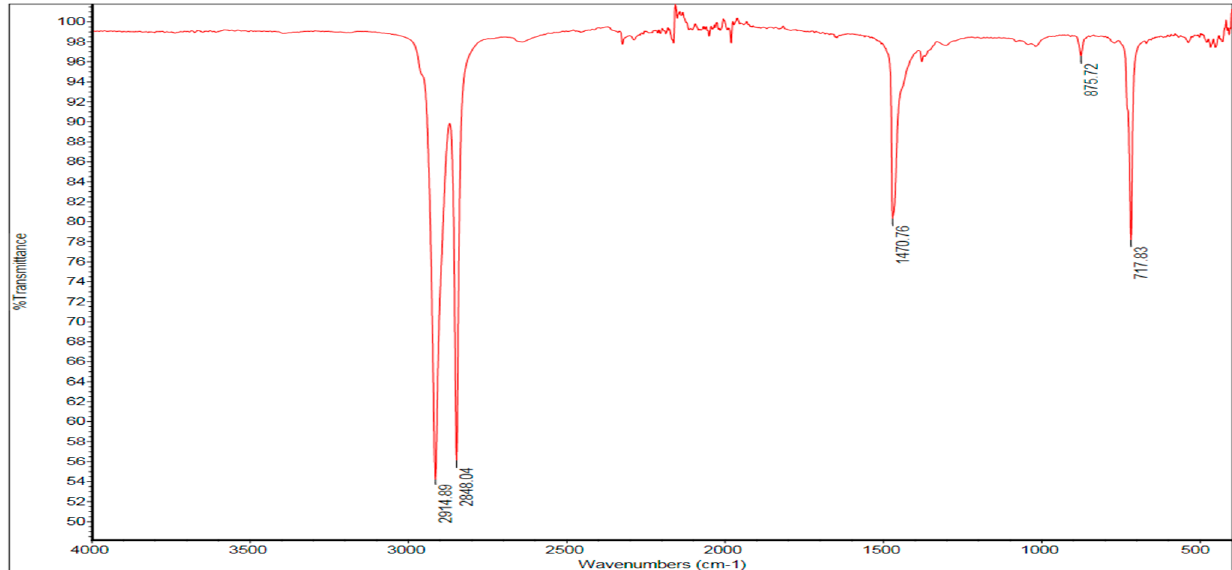
Figure 12. FTIR analysis of LLDPE after the addition of 3% weight pro-oxidant additive at day 0.